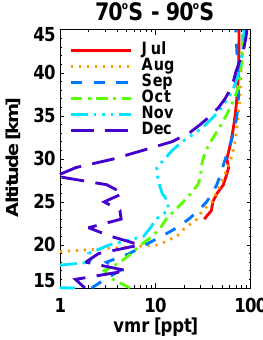
Fig. 12. Temporal evolution of mean Antarctic SO 2 vmr profiles in winter and